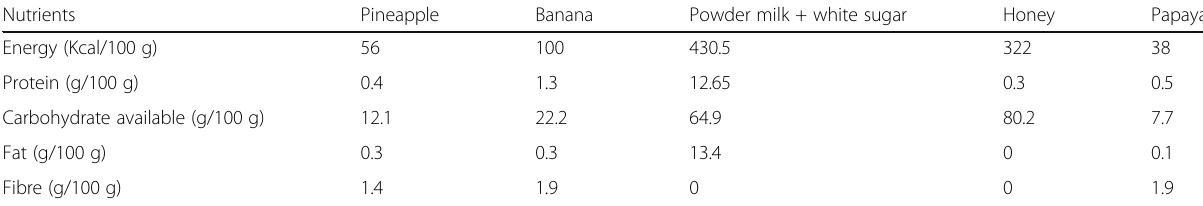
Table 1 Nutrients content of food used to feed housefly adults Nutrients